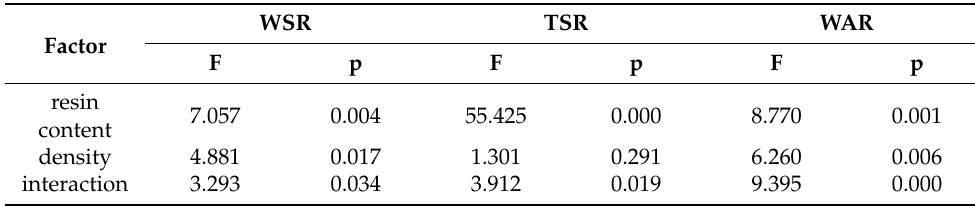
Table 2. Water-resistance data analyzed by ANOVA.